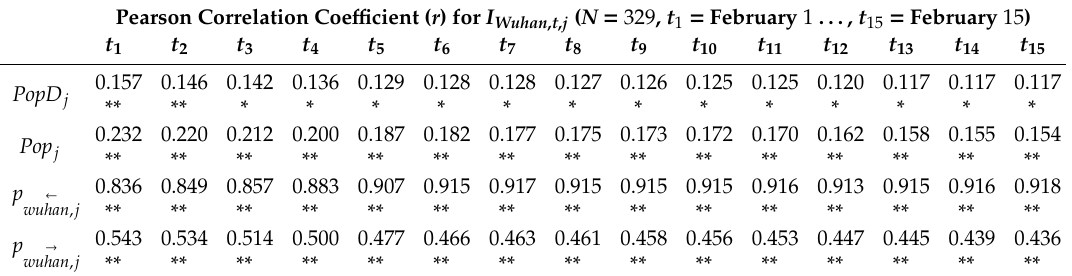
, p → with I Wuhan , t , j during Feb 1, wuhan , j wuhan , j